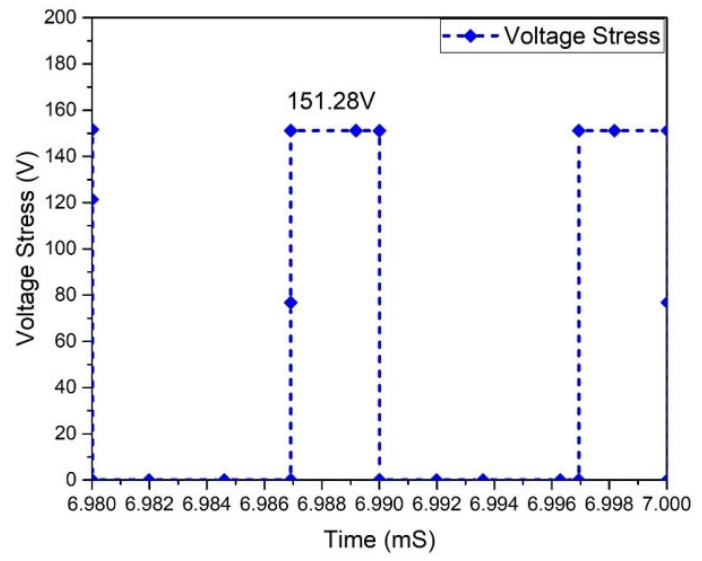
Figure 25. Voltage stress of MOSFETs.